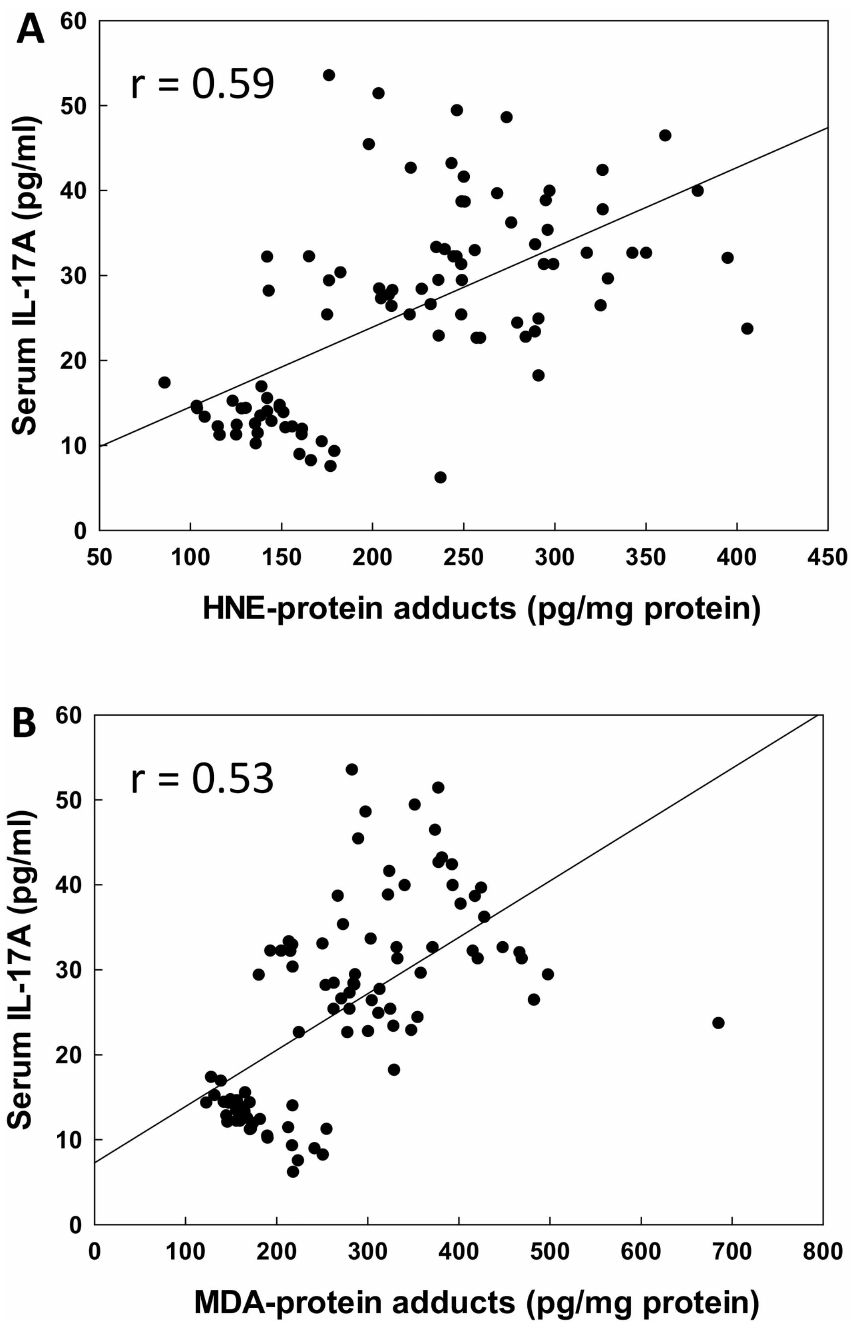
Fig 6. Correlation of serum HNE-protein adducts (A) or MDA-protein adducts (B) with IL-17A. The correlationwas establishedby calculating correlationcoefficients between serum HNE- or MDA-protein adducts and